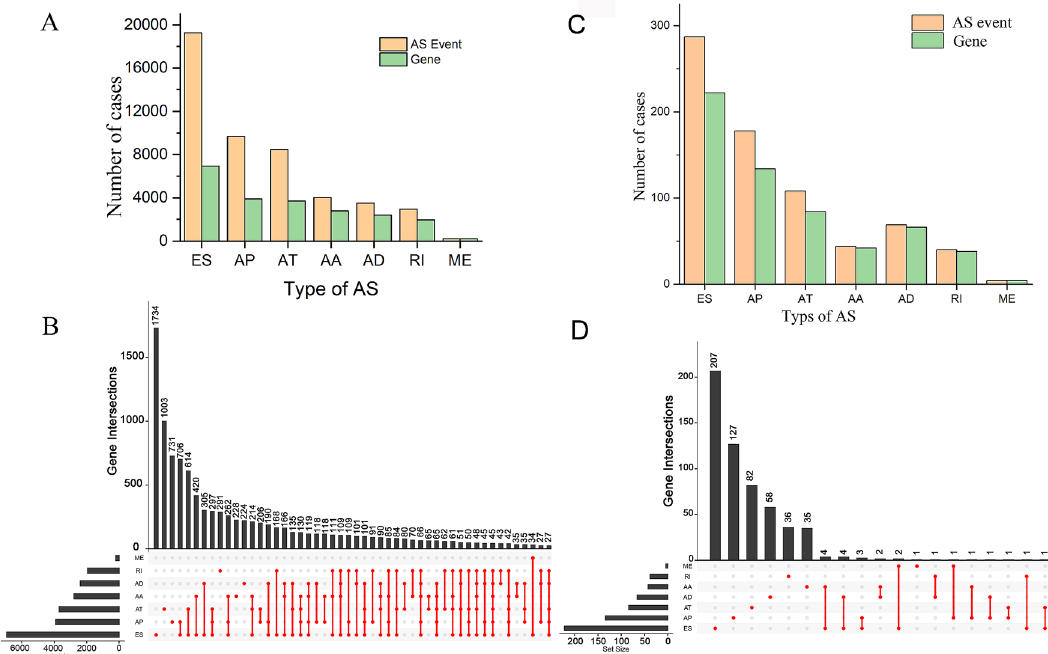
Figure 1. Overview and prognosis-associated AS events in this study. ( A ) Number of AS events and corresponding genes from 397 ovarian carcinoma patients. ( B ) UpSet plots in ovarian carcinoma showing the interactions among the seven types of AS events. One gene may have up to five types of AS events. ( C ) Number of prognosis-associated AS events and corresponding prognosis-associated genes obtained by using univariate COX analysis. ( D ) UpSet plots in ovarian carcinoma showing the interactions among the prognosis-related seven types of AS events. One gene may have up to two types of AS to be related with patient